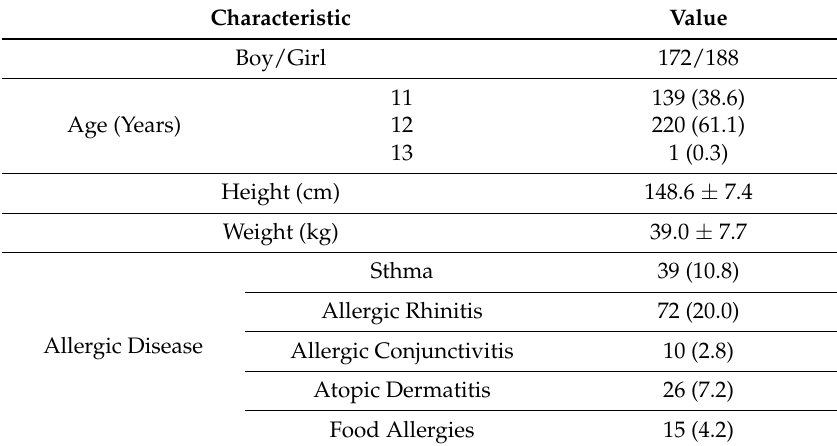
Table 1. Characteristics of the 360 children included in this study.